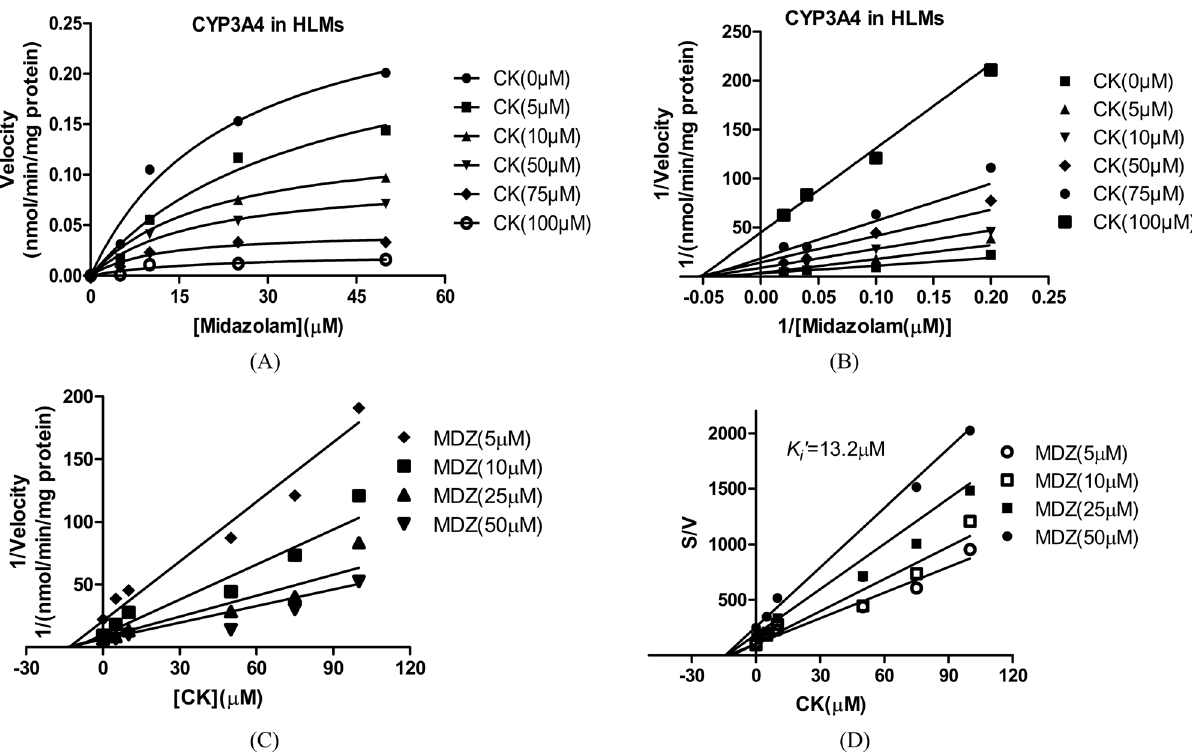
Fig 8. A nonlinear regression analysis curves of velocity (nmol/min/mg protein) enzyme activity for midazolam ( μ M) assuming Michaelis-Menten kinetics (A), representative Lineweaver-Burk plots (B) and Dixon plots (C) of the effect of CK on midazolam 1-hydroxylation formation and S/V versus [I] plots (D) in human liver microsomes. Note: The inhibition of CYP3A4 activity is best described as a noncompetitive inhibition by different concentrations of CK (10 – 100 μ M) in HLM incubations (0.5 mg (cid:3) mL -1 protein). The data points are the mean values of triplicate incubations. MDZ, midazolam.